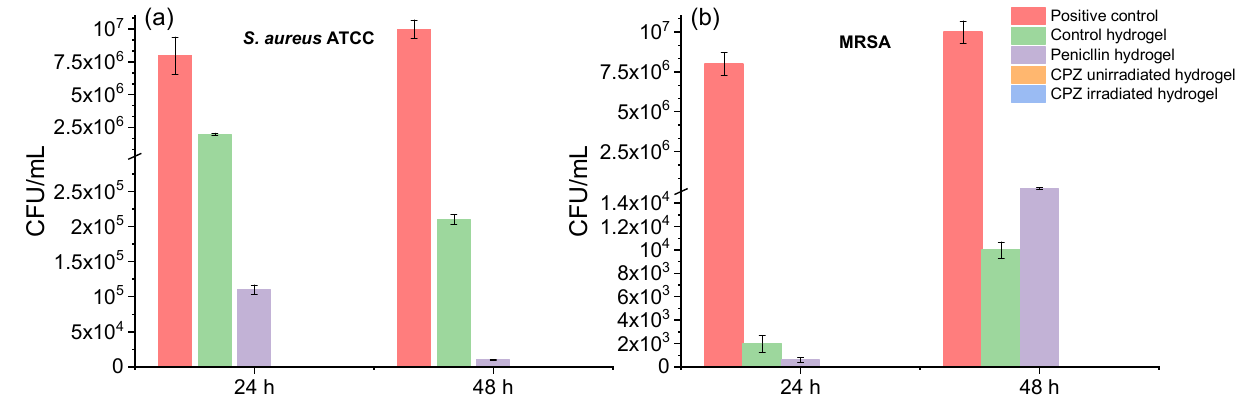
tegrity was established by in vitro methods (MTT and LDH) assessed on normal fibroblasts. Morphological modifications were also investigated by optical microscopy.